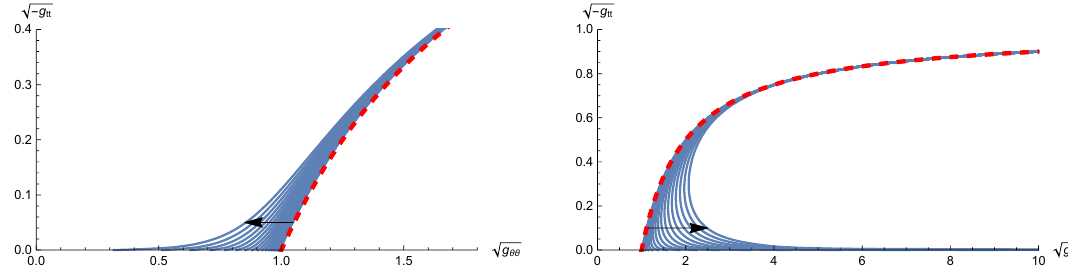
Figure 11 . Similar figure to the previous one, but now for flows that begin with a small perturbation of the electrically charged extremal RN solution. The perturbation is subtracted and added to initially decrease and increase the horizon size, giving the left and right frames plotted for flow time intervals ∆ λ = 0 . 1 and 0 . 25 respectively. The flow behaviour at the extremal horizon decouples and follows the near horizon flow, leading to a collapse in finite flow time or exponential horizon